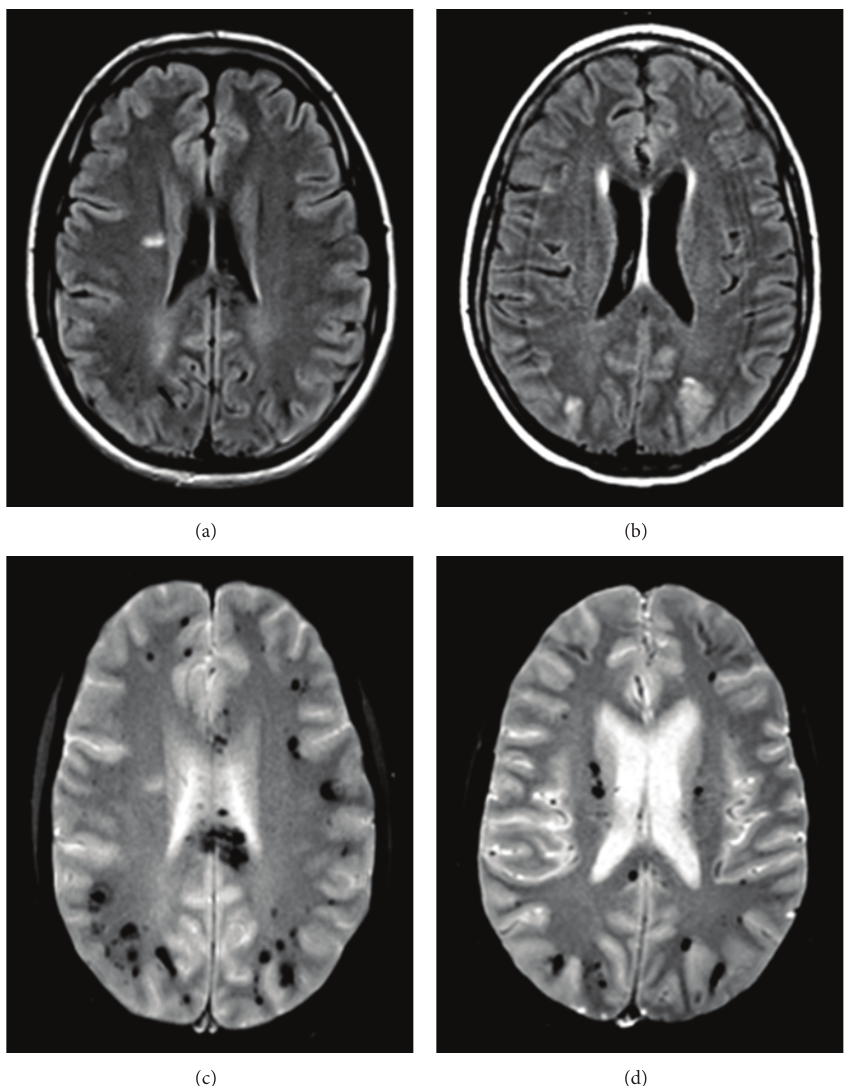
Figure 1: Axial FLAIR images of the 2 patients (a, b, resp.) showing right periventricular hyperintensity in case 1 and bilateral occipital hyperintensities in case 2; T2 ∗ -weighted sequences of the 2 patients (c, d, resp.) showing both cerebral microbleeds in the cortico-subcortical junction of the two cerebral hemispheres associated with cerebral microbleeds in corpus callosum in case 1 and frontal subarachnoid hemorrhage in case